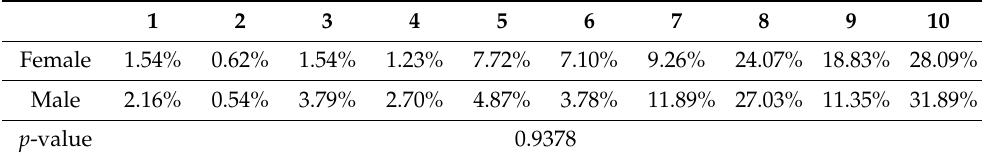
Table 2. Degree of similarity between their “I” inside and outside social networks. 1